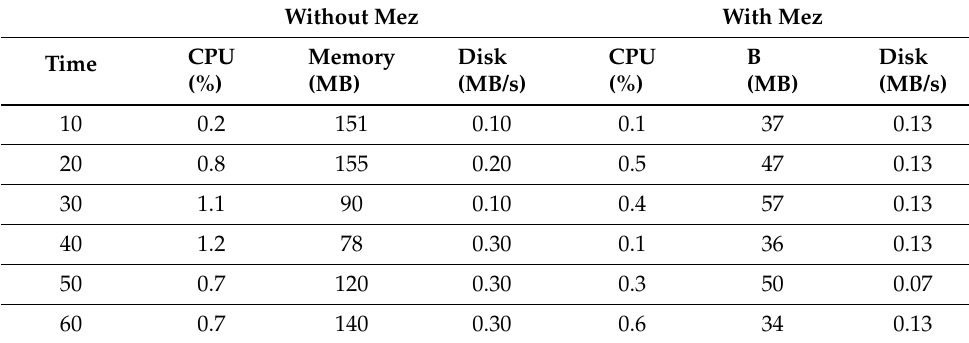
Table 7. The cloud resource optimization statistics over 60